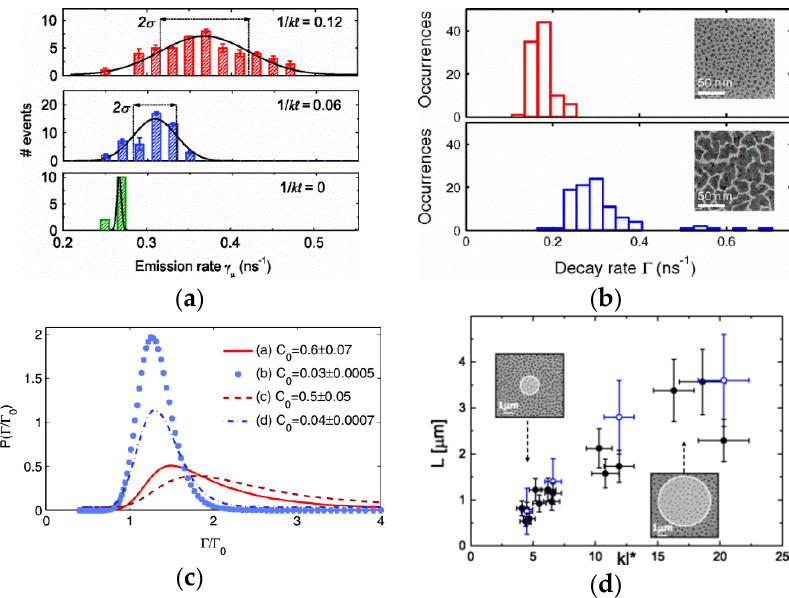
Figure 5. ( a ) Distribution of the emission rates of dye ‐ spheres for materials with different scattering strengths (1/ kl ), ZnO (red histogram), polystyrene latex random photonic media (blue histogram) and nonscattering polymer layer (green histogram). ( b ) Decay rate distributions of fluorescent polystyrene beads on two disordered fractal metal films, isolated gold nanoparticles, and fractal clusters with gold filling fraction of 30% (red histogram) and 82% (blue histogram), respectively. ( c ) Numerical distributions of the decay rate of fluorescent polystyrene beads for four different systems with the same values of kl = 9.4 and R = 0.63 µ . ( d ) Characteristic length scale L as a function of kl *. Figures reproduced from ( a ) Birowosuto, M.D. et al. Phys. Rev. Lett. 2010 , 105 , 013904. Copyright 2010 by American Physical Society; ( b ) Krachmalnicoff, V., et al. Phys. Rev. Lett. 2010 , 105 , 183901. Copyright 2010